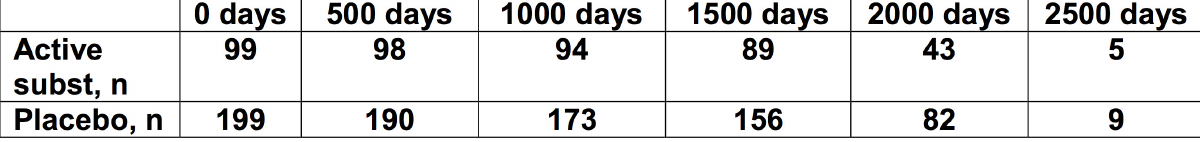
Fig 3. Kaplan-Meier graph illustrating cardiovascular mortality in the study population with a plasma selenium concentration < 65 μ g/L divided into those given selenium and coenzyme Q10 combined versus those given placebo or no treatment during a follow-up period of 5.2 years. Censored: patients who were still alive at the end of the follow-up period, or who died from non-cardiac causes. Complete: Patients who died from cardiovascular causes during the follow-up period.